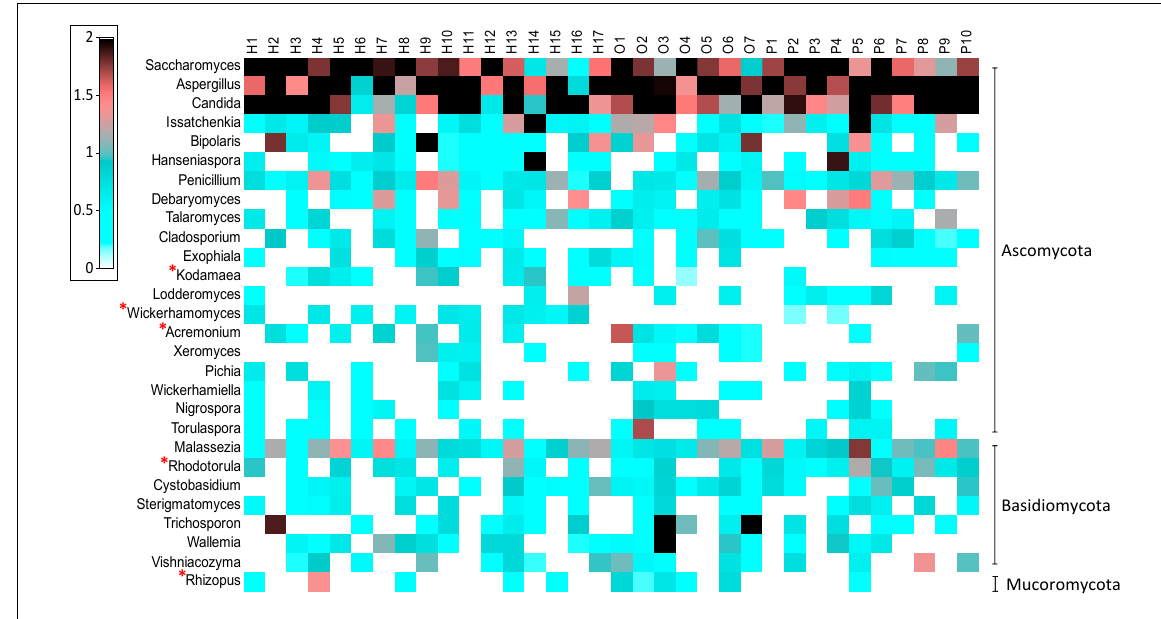
Figure 3. The relative abundance of fungal genera and prevalent compromising the gut mycobiome of healthy and atopic dermatitis infants. The heat map portraying the relative abundance (root four value) of each taxon per infant (H—healthy, O—outgrown, P—persisted). The genera marked with a red asterisk differed significantly between the three groups ( p -value 0.05).